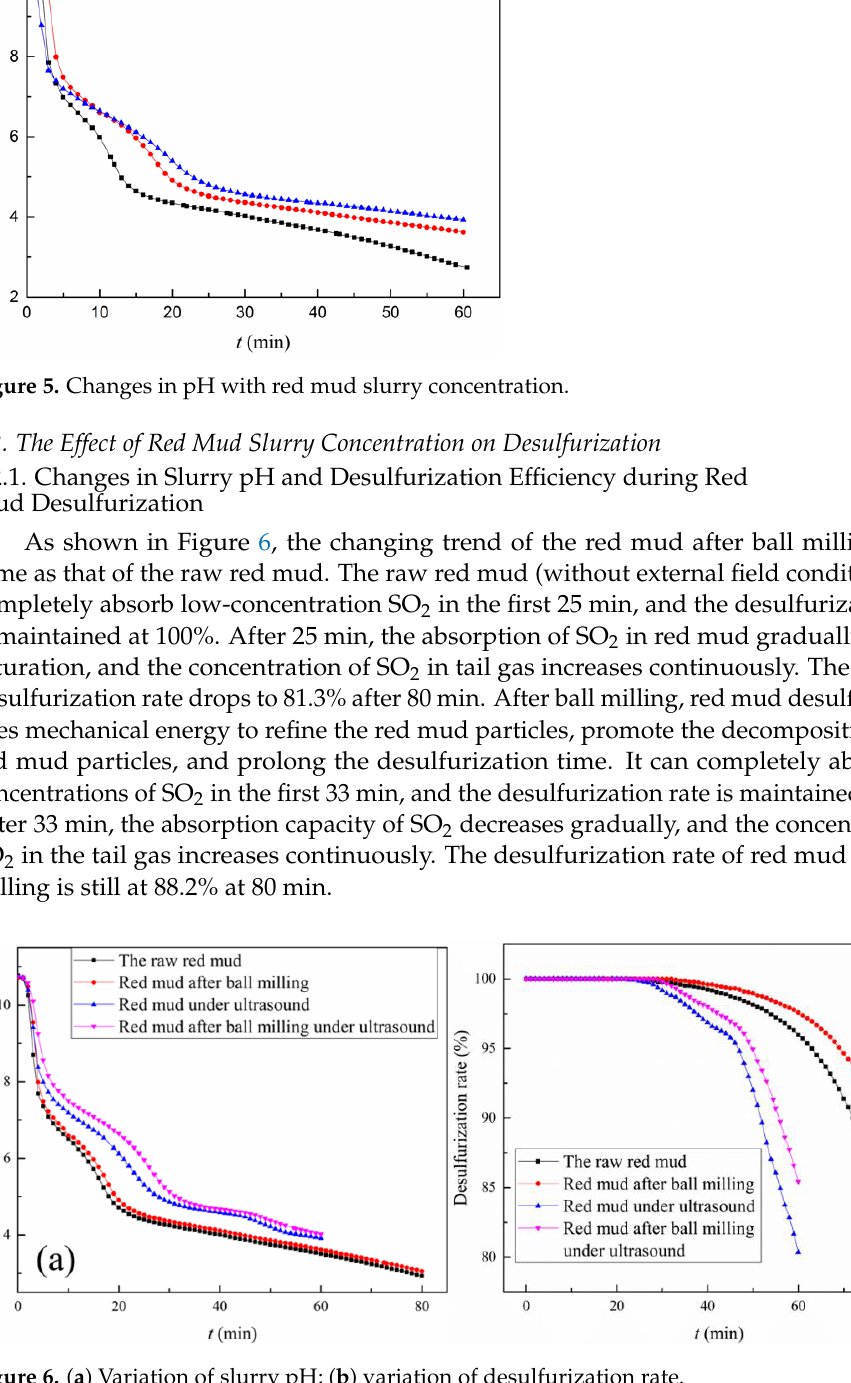
Figure 6. ( a ) Variation of slurry pH; ( b ) variation of desulfurization rate.